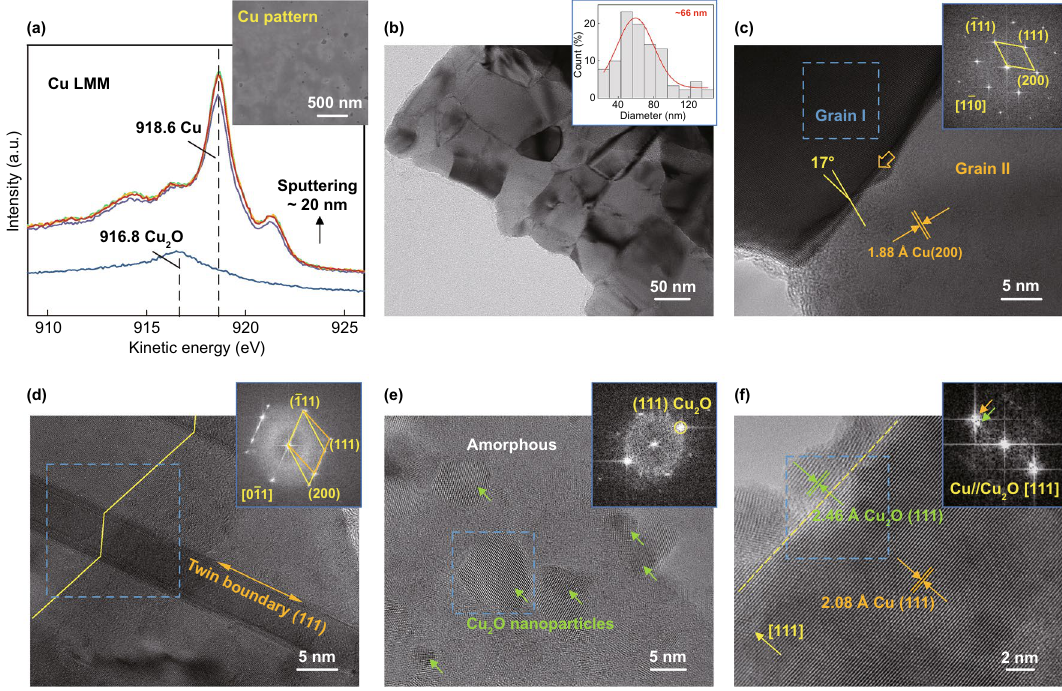
Fig. 2 Characterization of the typical written pattern. a Cu LMM spectra of the pattern obtained at 10 N w as a function of the sputter depth. Inset SEM image shows the morphology of the typical pattern. TEM images of the b – d typical dense Cu and e – f Cu 2 O structures in the pattern. Inset image in b is the statistics of the particle size. Insets in c – f are the FFT images corresponding to the regions marked by the blue dotted